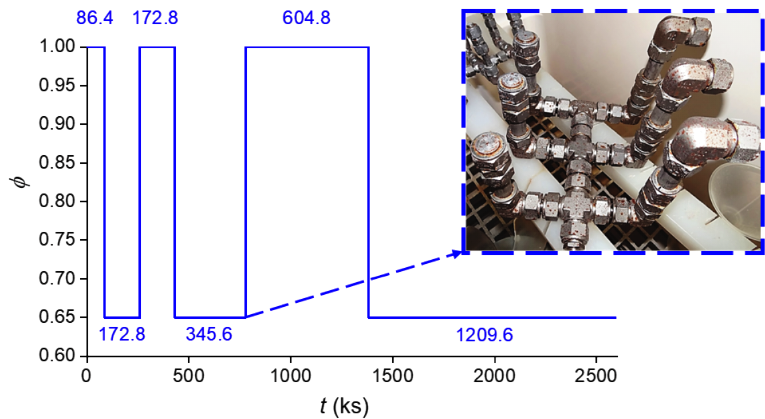
Figure 2. Stress–corrosion testing protocol: 2.6Ms (720h) at 338K, cyclic between two distinct levels of relative humidity, φ 1 = 1.00, φ 2 = 0.65, for increasing durations t 1 , t 2 as shown in the diagram. The inset shows tested tube fitting system after